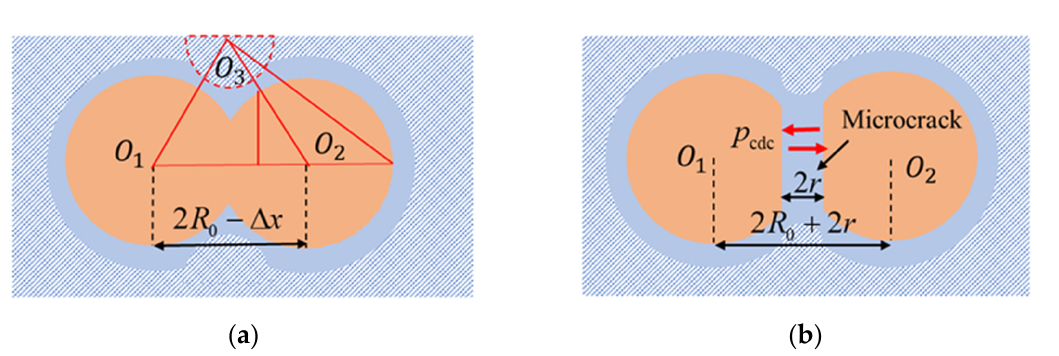
Figure 4. Schematic diagram of the initial microcrack due to freezing. Where ( a ) represents the geometric relationship between adjacent clay particles before micro-cracks occur; ( b ) represents the geometric relationship between adjacent clay particles after micro-cracks.